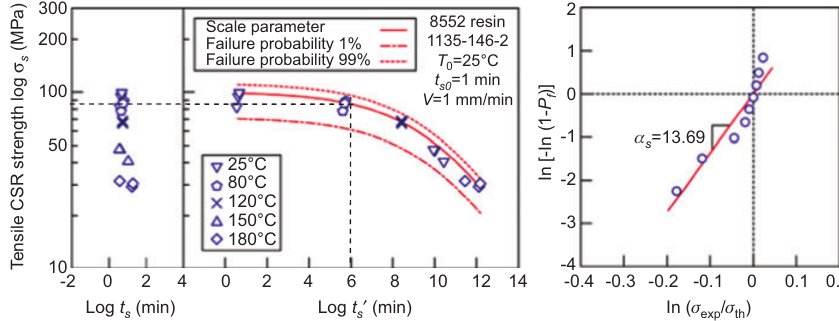
Figure 14 Master curve for tensile strength ( T